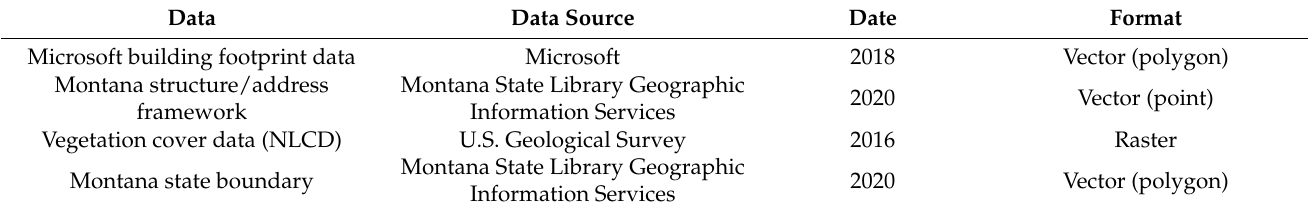
Table 1. The datasets used in this